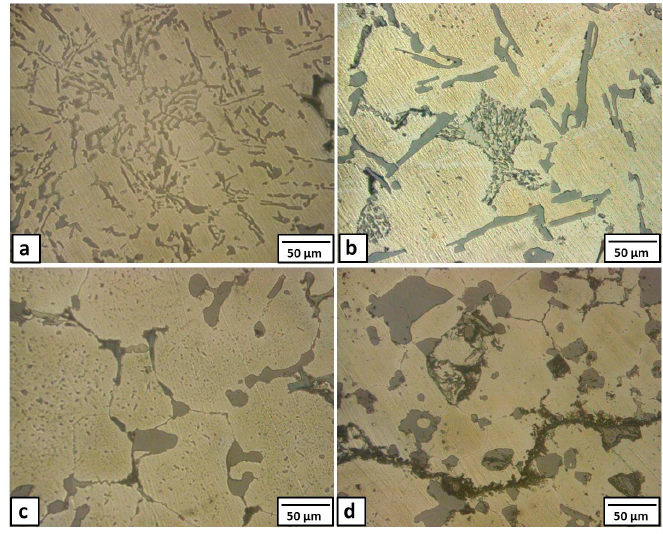
Figure 7. Optical micrographs of the formed composite from the addition of 6% Cu after heat treatment at ( a ) 380 °C for 6 h; ( b ) 380 °C for 18 h; ( c ) 450 °C for 6 h; and ( d ) 450 °C for 18 h.